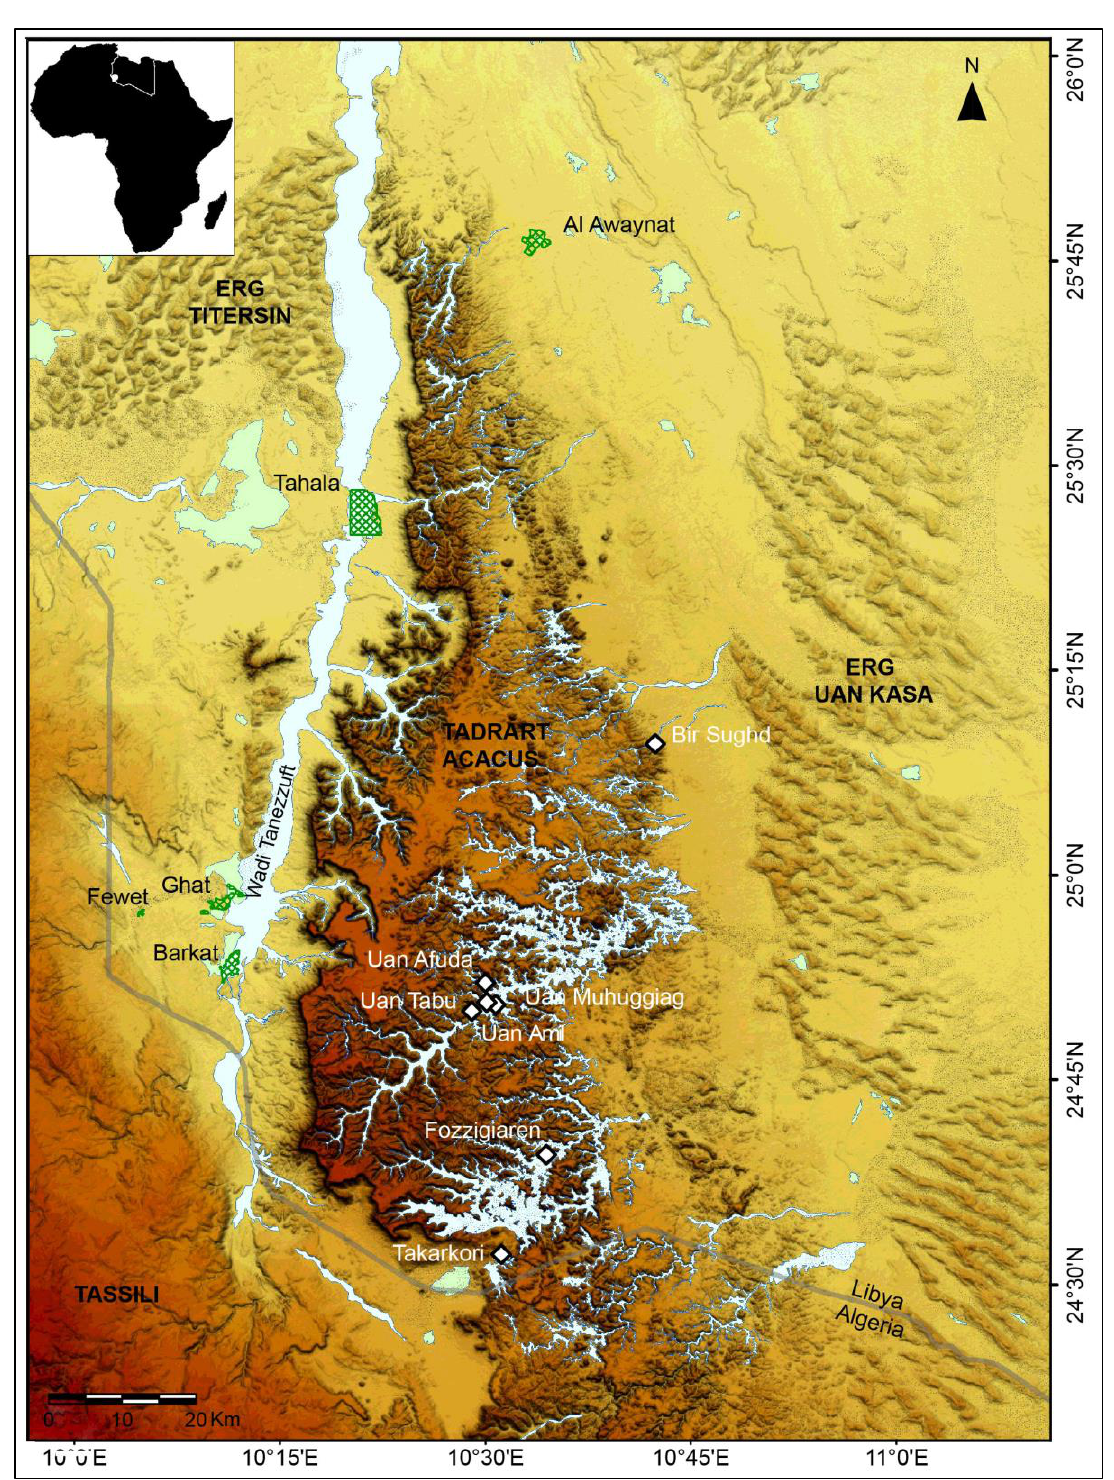
aridity state, even if with different timing and evolution, depending on the different physiographic units [62]. Figure 2. Map of Tadrart Acacus with the location of sites and localities cited in the